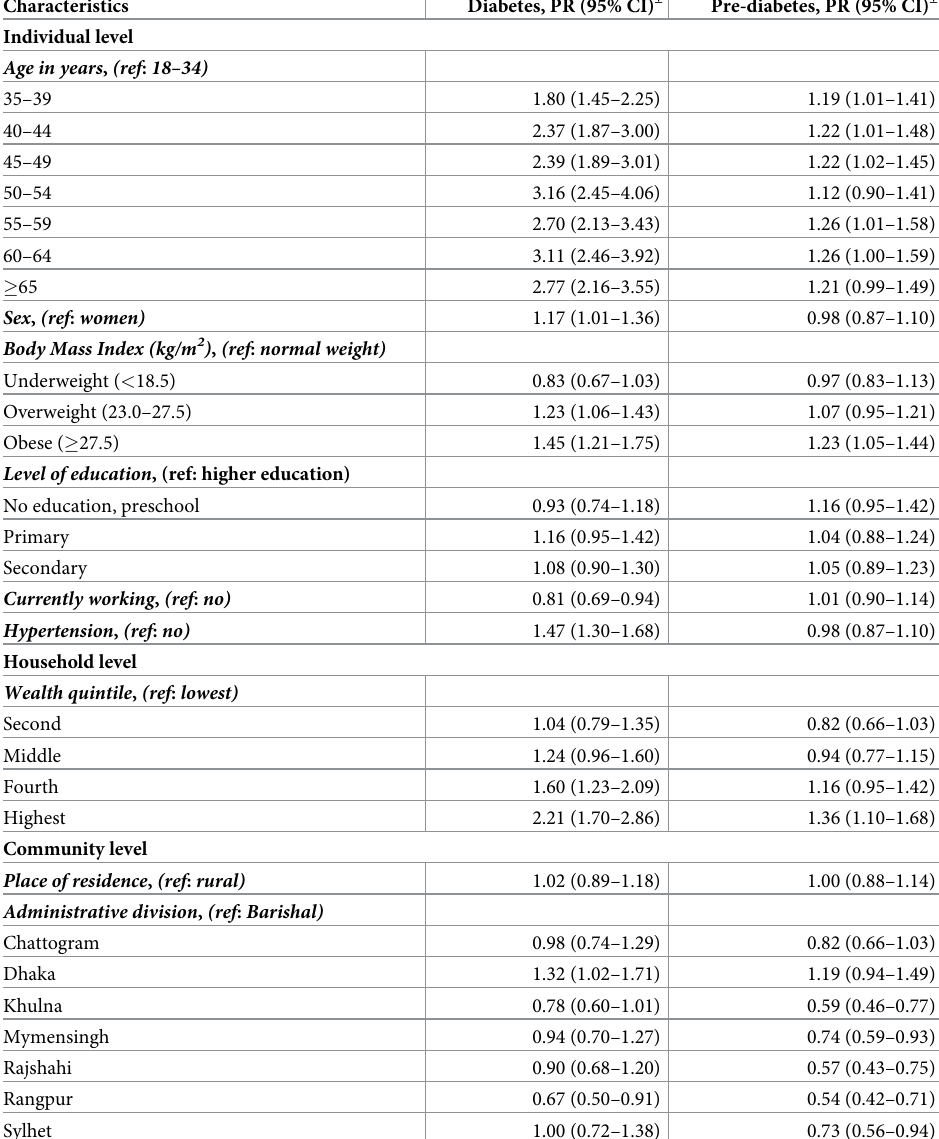
Table 4. Factors associated with diabetes and prediabetes in adults aged � 18 years in Bangladeshi population, BDHS 2017–18. Characteristics